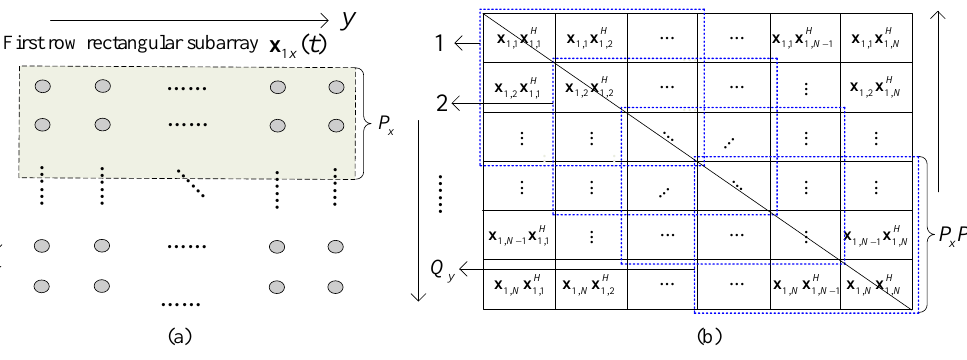
Figure 2. ( a ) The first row rectangular subarray ( b ) Its covariance